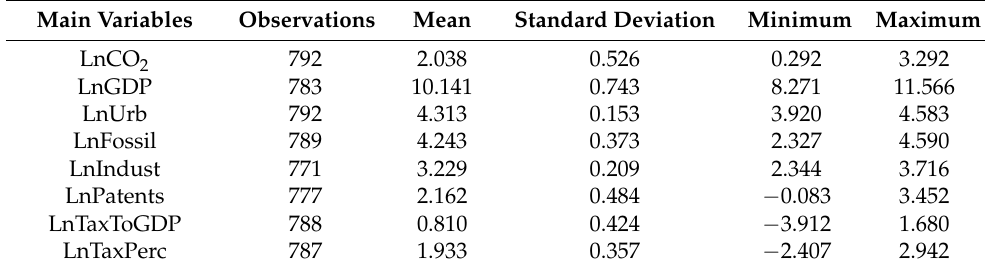
Table 2. Variables’ Descriptive